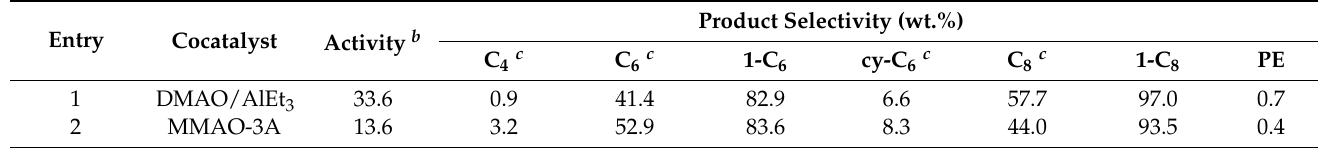
Table 7. Evaluation of the effect of cocatalyst on the catalytic performance of L2-based catalysts a